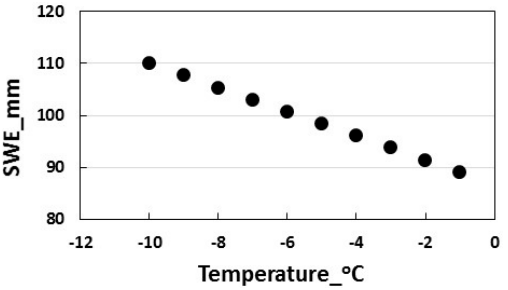
Figure 8. The relationship between temperature and SWE at X band under the fixed absorption part of optical thickness 0.0057 at X band.